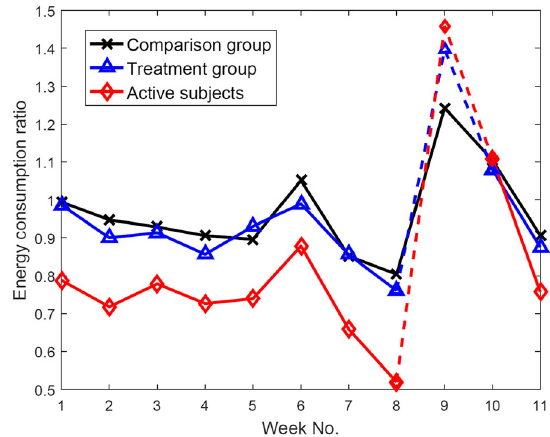
Fig. 6 Energy consumption ratio at 1 – 7 pm for experiment ( ‘ 17) based on the consumption of same days in 2016 (Historical consumption data for some treatment group subjects in Week 9, 2016 is not available. We use dashed lines to show the less reliable trend between Week 8 – 9 and 9 –